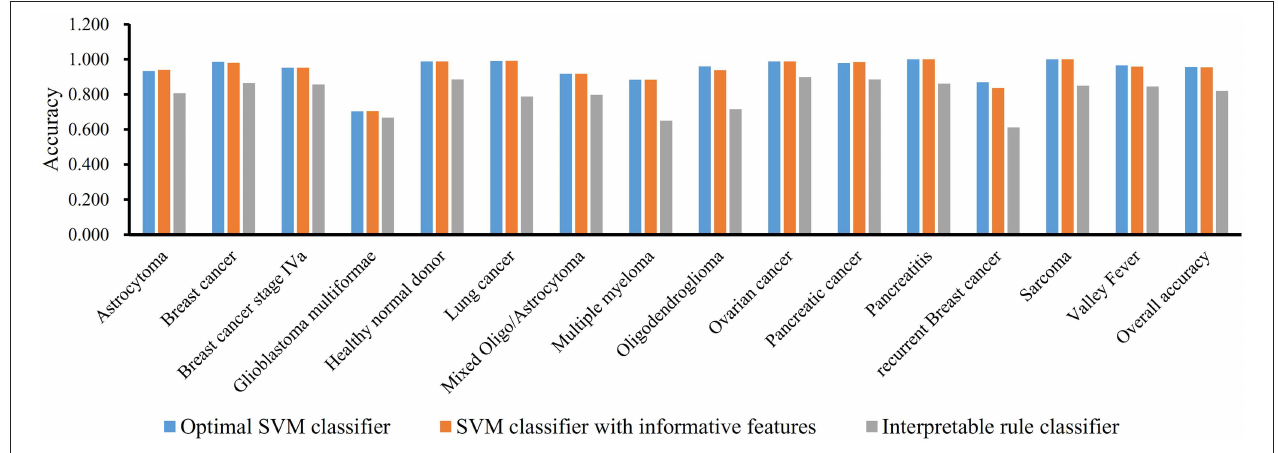
FIGURE 6 | Performance of three classifiers on 15 groups in dataset-2 and overall accuracy.